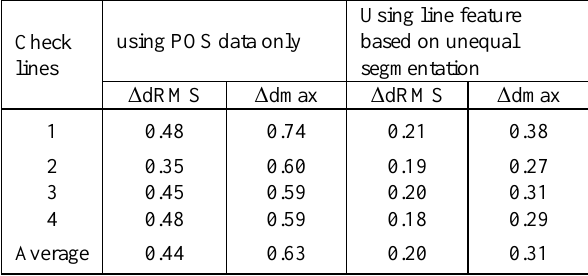
Table 2. Relative precision evaluation by check lines (Unit: